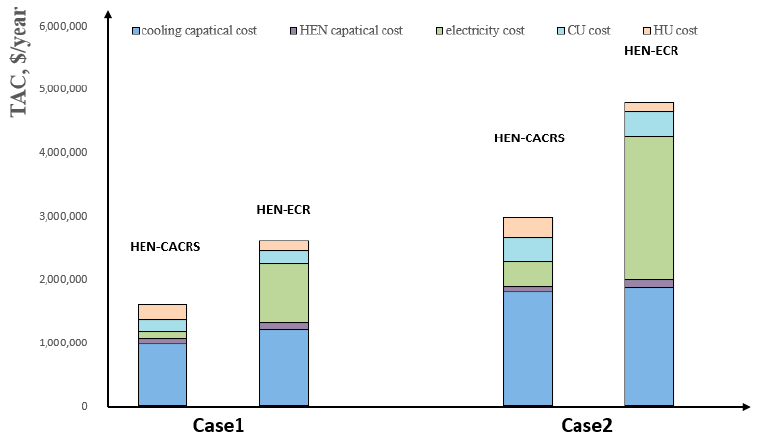
Figure 6. The distribution of total annual cost.